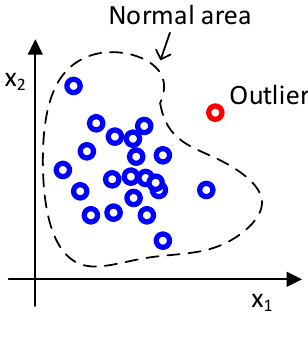
Figure 10. Outlier